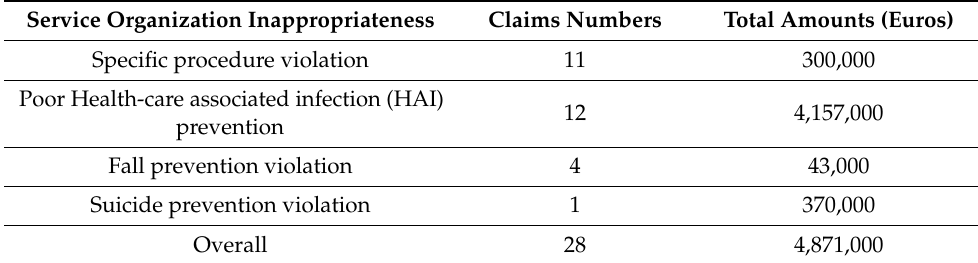
Table 3. Service organization inappropriateness.